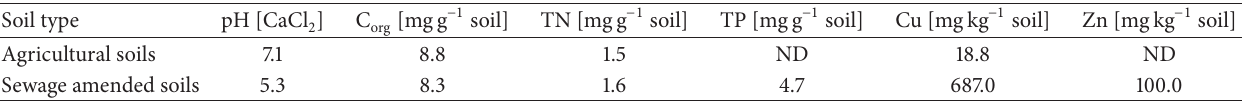
Table 1: Initial pH, organic carbon (C ), total nitrogen (TN), total phosphorus (TP), and Cu and Zn contents of the agricultural and sewage org amended soils used in the greenhouse experiment.